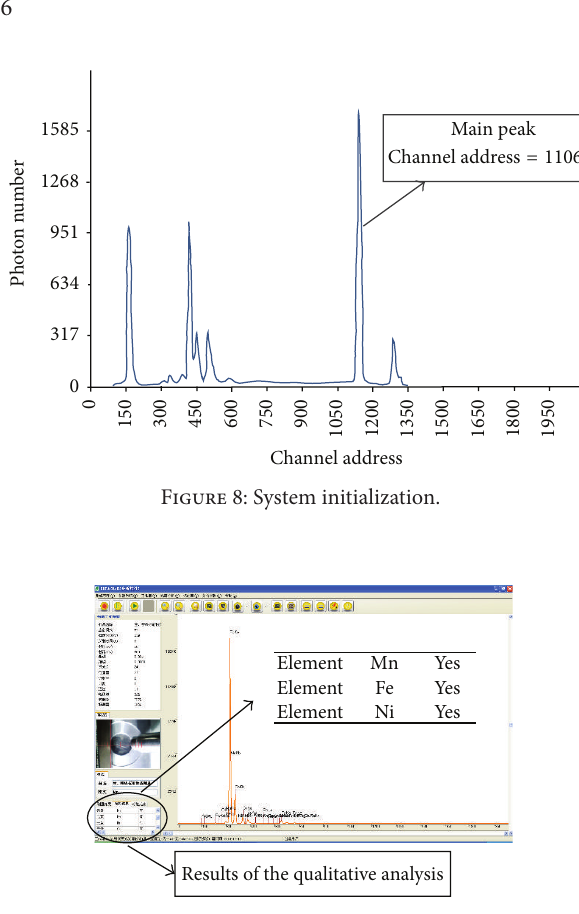
Figure 9: Results of the qualitative analysis.